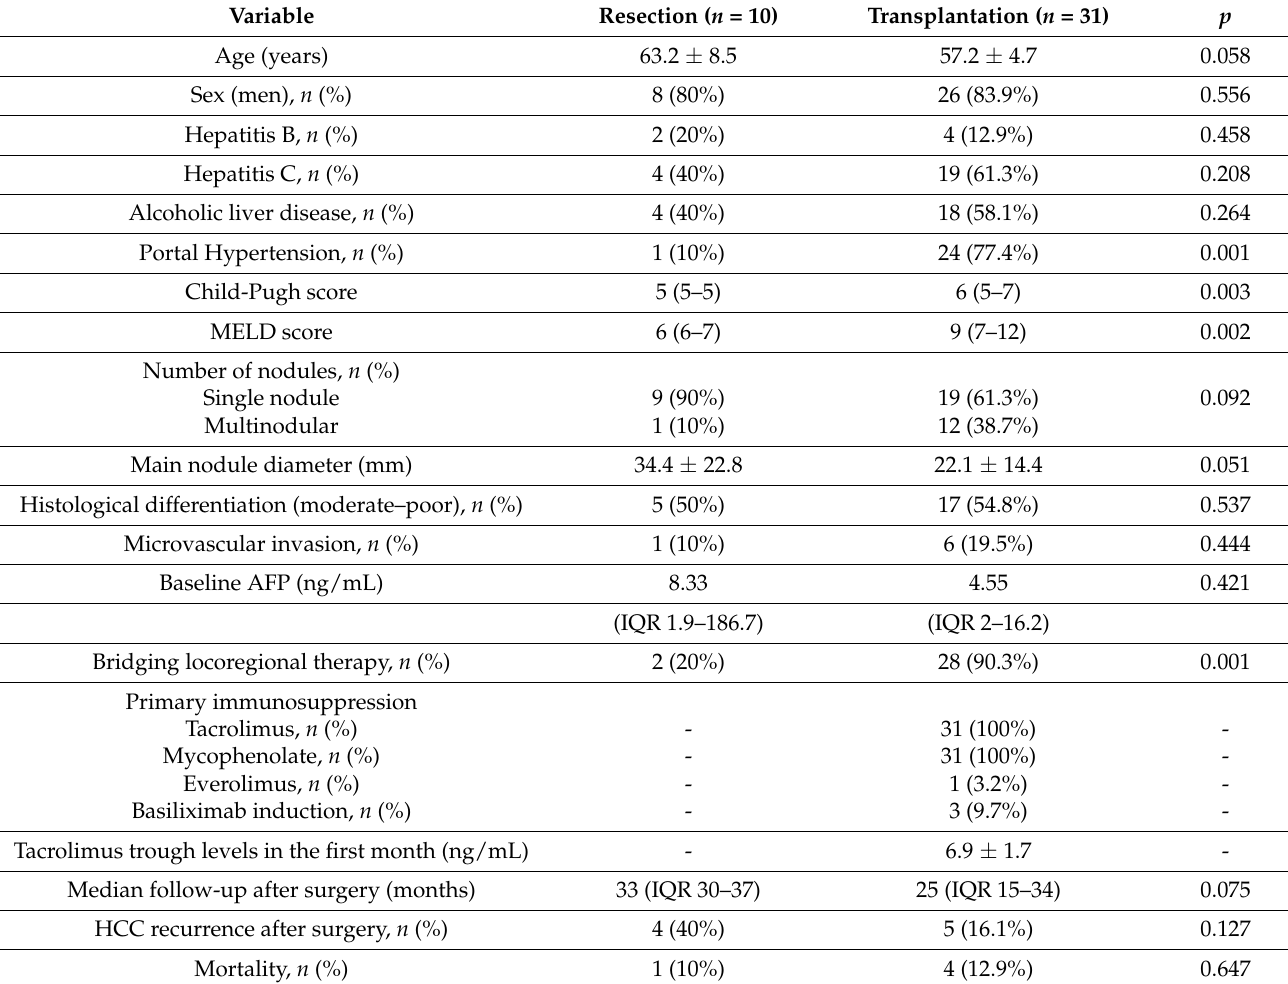
Table 1. Baseline characteristics of patients undergoing curative